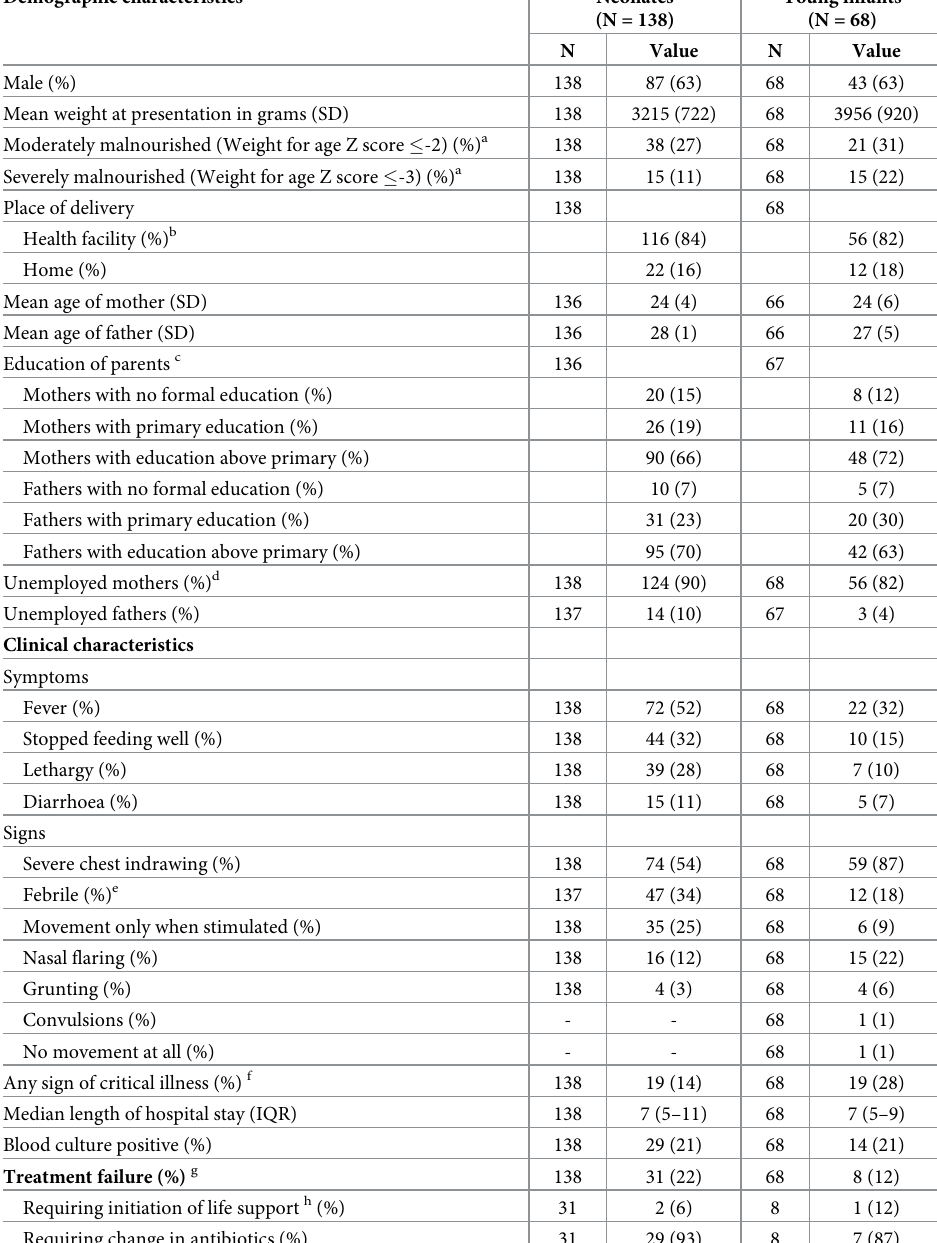
Table 1. Baseline characteristics of study participants hospitalized with clinical severe infection at Kanti Chil- dren’s Hospital. Demographic